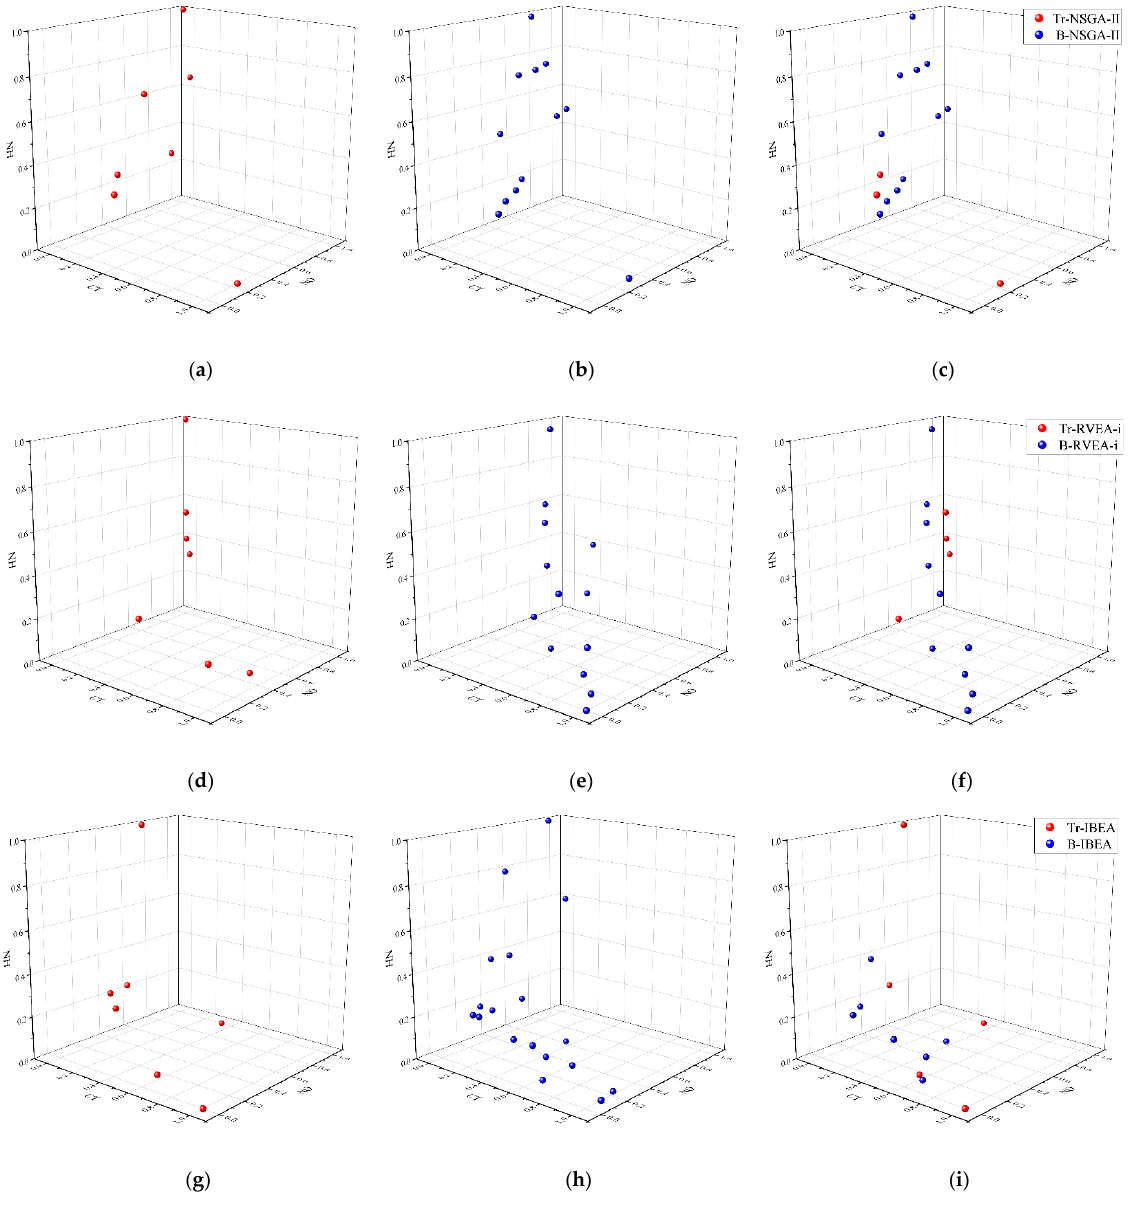
Figure 7. Normalised nondominated solution set of problem S2. ( a ) Tr-NSGA-II; ( b ) B-NSGA-II; ( c ) Tr-NSGA-II and B-NSGA-II; ( d ) Tr-RVEA-i; ( e ) B-RVEA-i; ( f ) Tr-RVEA-I and B-RVEA-i; ( g ) Tr-IBEA; ( h ) B-IBEA; ( i ) Tr-IBEA and B-IBEA.